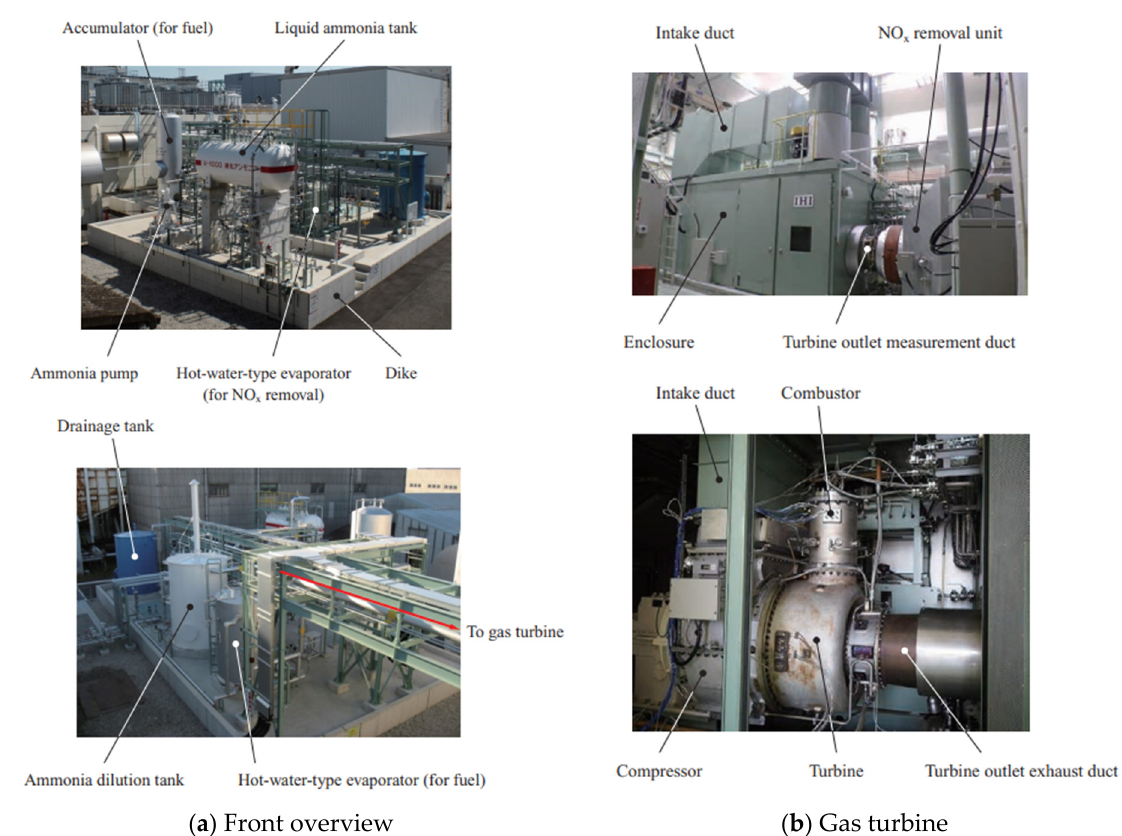
Figure 21. IHI’s 2 MW-class NH 3 gas turbine system: ( a ) Apparatus of NH 3 supply unit; ( b ) Apparatus of gas turbine. Modified from [109]. Courtesy of Ammonia Energy Association [109].